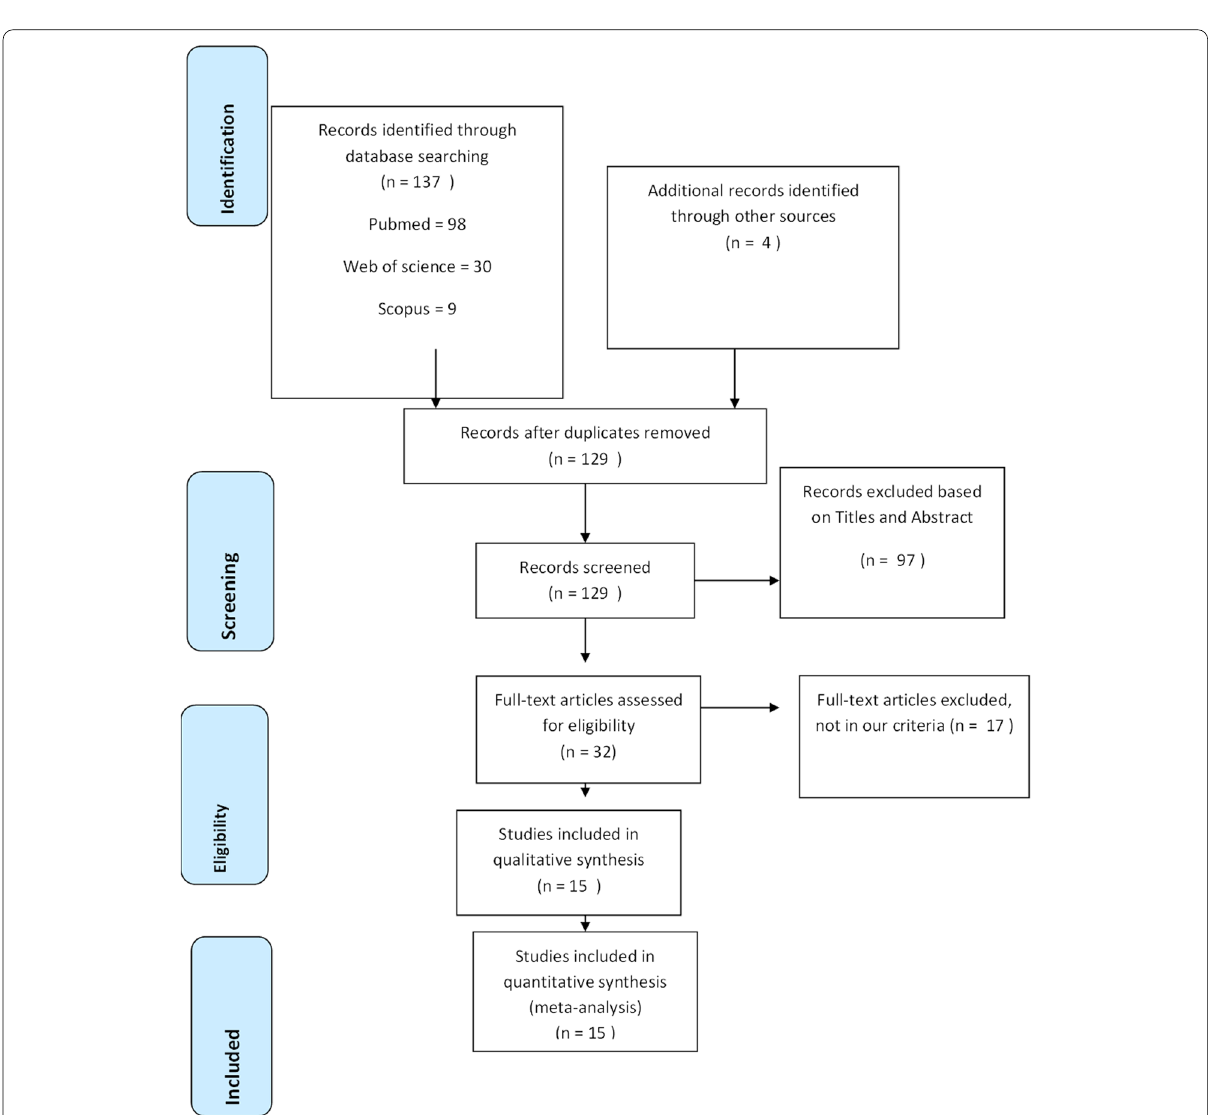
Fig. 1 PRISMA flow diagram summarizing the literature search. PRISMA Preferred Reporting Items for Systematic Reviews and